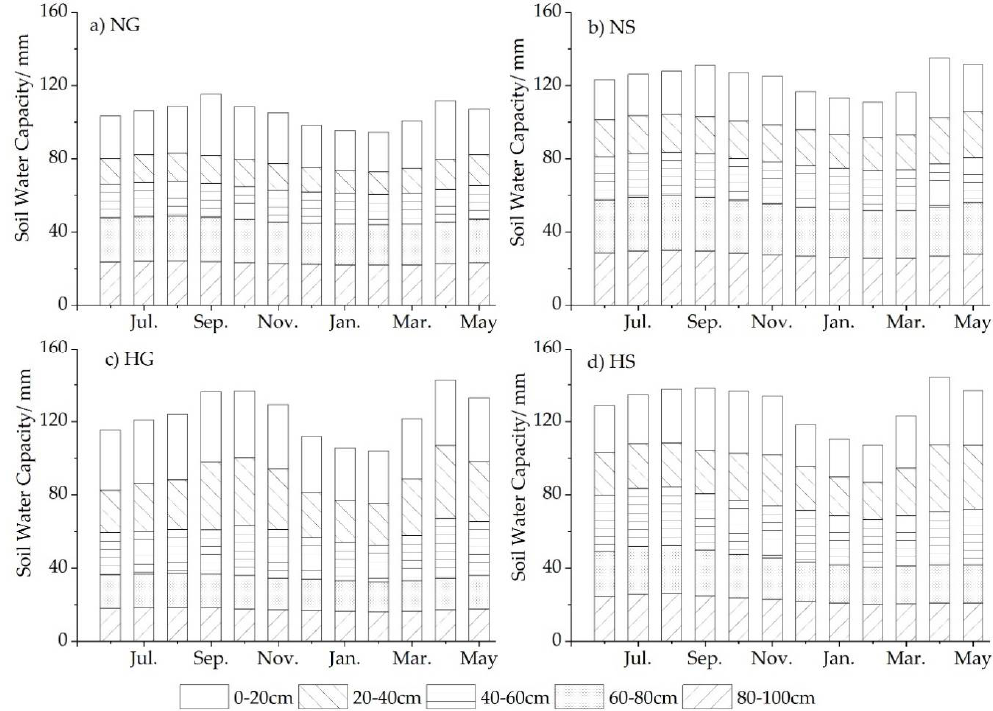
Figure 3. The monthly dynamics of soil water storage in four sites from June 2015 to May 2016. ( a )soil water capacity under natural grass (NG) patch; ( b ) soil water capacity under natural shrub (NS) patch; ( c ) soil water capacity under harvesting grass (HG) patch; ( d ) soil water capacity under harvesting shrub (HS) patch.